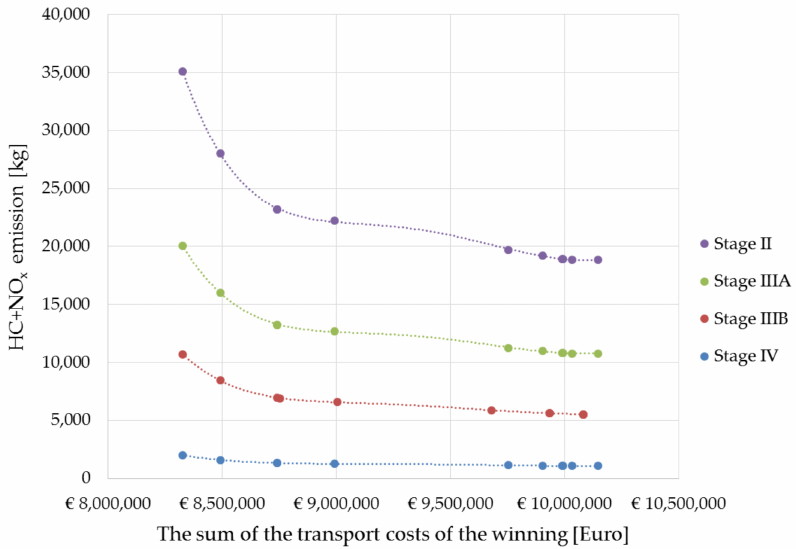
Figure 12. The level of HC+NO x emissions during transport of the winning depending on the standards met by loaders and haulage vehicles; In each case, the proposed method of selecting means of transport was